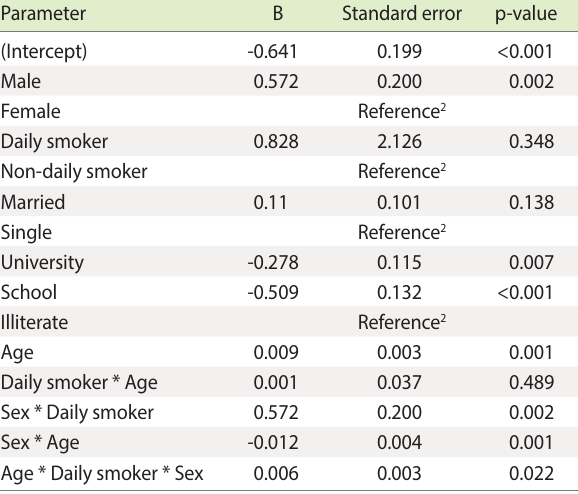
Table 2. Results of multivariable logistic regression 1 Table 3. Odds ratios of having dry mouth by age, sex, and